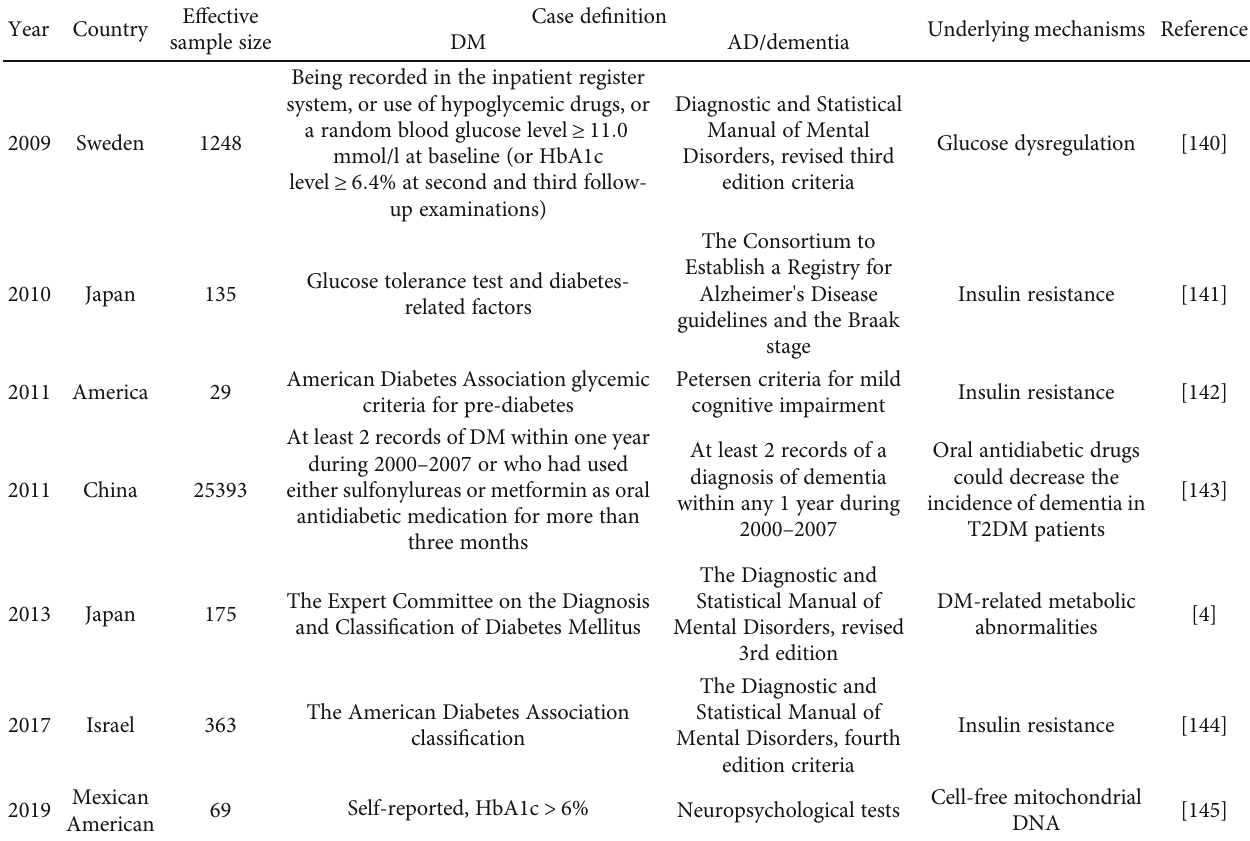
Table 1: Summary of epidemiological research on DM and AD in recent ten